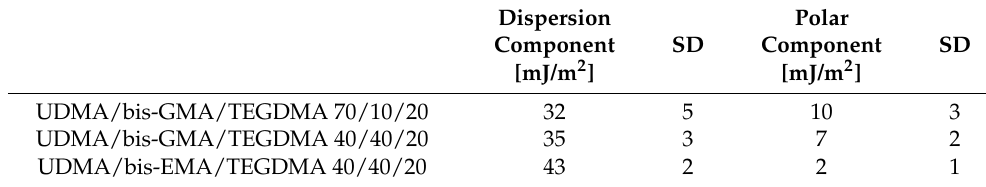
Table A6. Results of dispersion and polar components calculations for